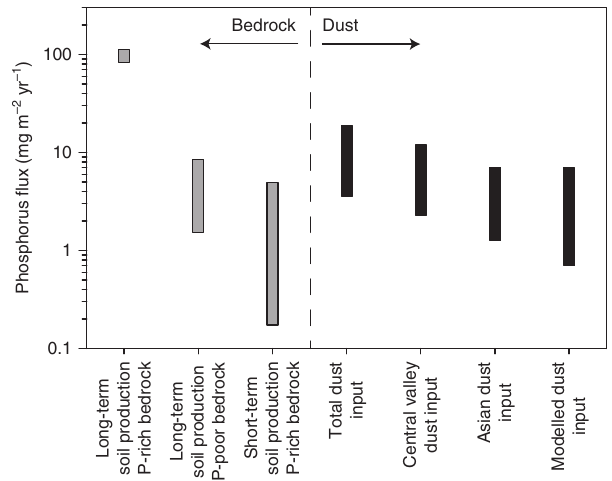
Figure 5 | Phosphorus fluxes. Fluxes of the plant-essential macronutrient phosphorus at the Providence Creek study site due to erosion (grey bars) and aeolian deposition (black bars). Bars span ranges in fluxes from multiple measurements (see Supplementary Dataset 2). Total dust flux is the sum of fluxes from Asian and Central Valley sources. On soil-mantled slopes, the total input of P from dust accounts for 10–20% of the supply of bedrock P implied by coupling long-term erosion rates with concentrations of P in bedrock. On bare-rock slopes, the estimated supply of bedrock P is much lower and commensurate with the fluxes from the Asian and Central Valley dust sources, due to slower erosion and lower concentrations of P in bedrock. The fluxes of P implied by catchment-wide sediment yields averaged over a recent seven-year interval are generally slower than the estimated dust fluxes, implying that the modern ecosystem is strongly influenced by the day-to-day contributions of dust from Asia and the Central